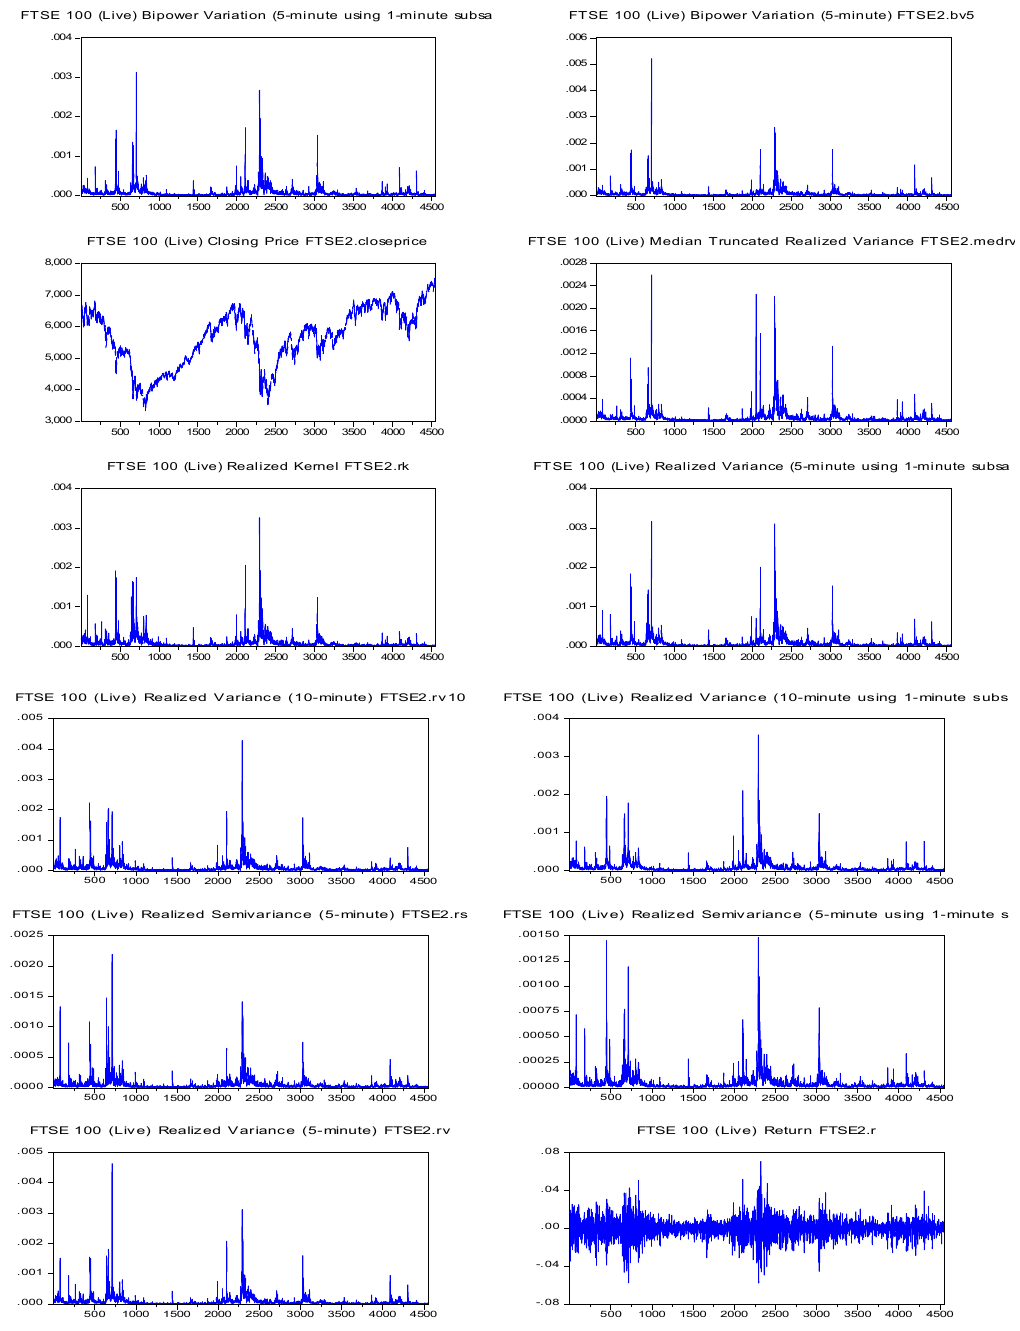
Figure 2. FTSE100 plots. Note: This set of figures depict the realized measures on the FTSE100 index (from left to right): The first figure depicts the realized bi-power variation (5-min sub-sampled) estimator, the second figure depicts the realized bi-power variation (5-min) estimator, the third figure depicts the FTSE100 index closing price, the fourth figure depicts the median realized variance (5-min) estimator, the fifth figure depicts the realized Kernel variance estimator (two-scale/Barlett), the sixth figure depicts the realized variance (5-min sub-sampled) estimator, the seventh figure depicts the realized variance (10-min) estimator, the eighth figure depicts the realized variance (10-min sub-sampled) estimator, the ninth figure depicts the realized semi-variance (5-min) estimator, the tenth figure depicts the realized semi-variance (5-min sub-sampled) estimator, the eleventh figure depicts the realized variance (5-min) estimator, and the twelfth figure depicts the return of the FTSE100 index.